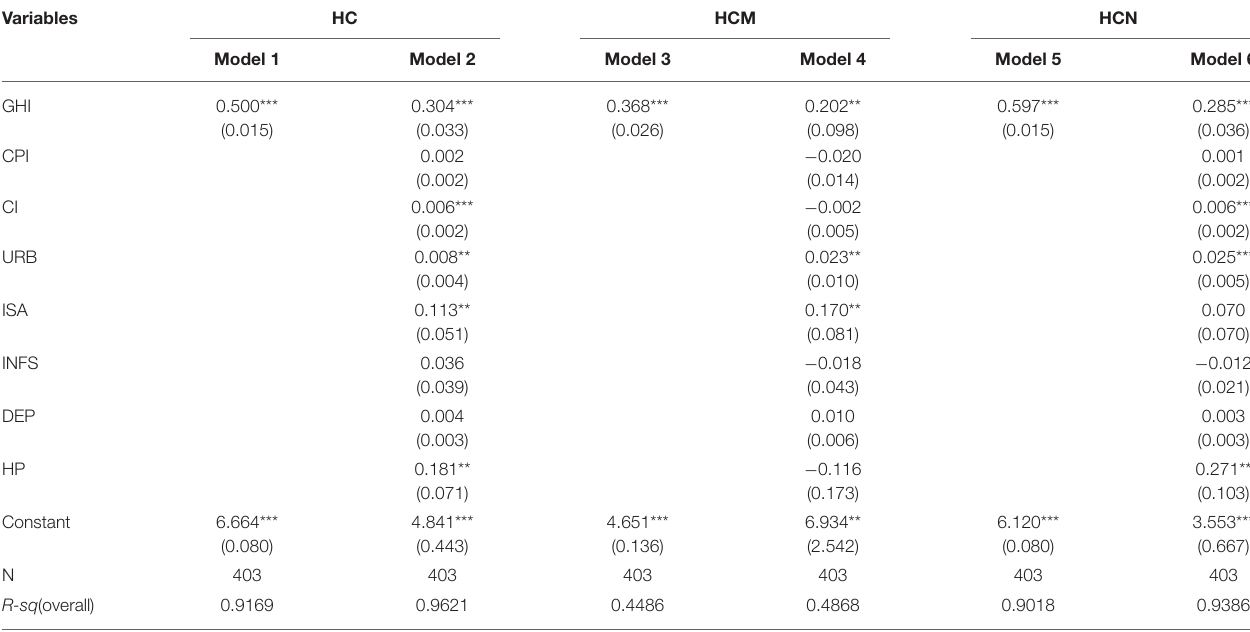
TABLE 3 | Regression analysis results.